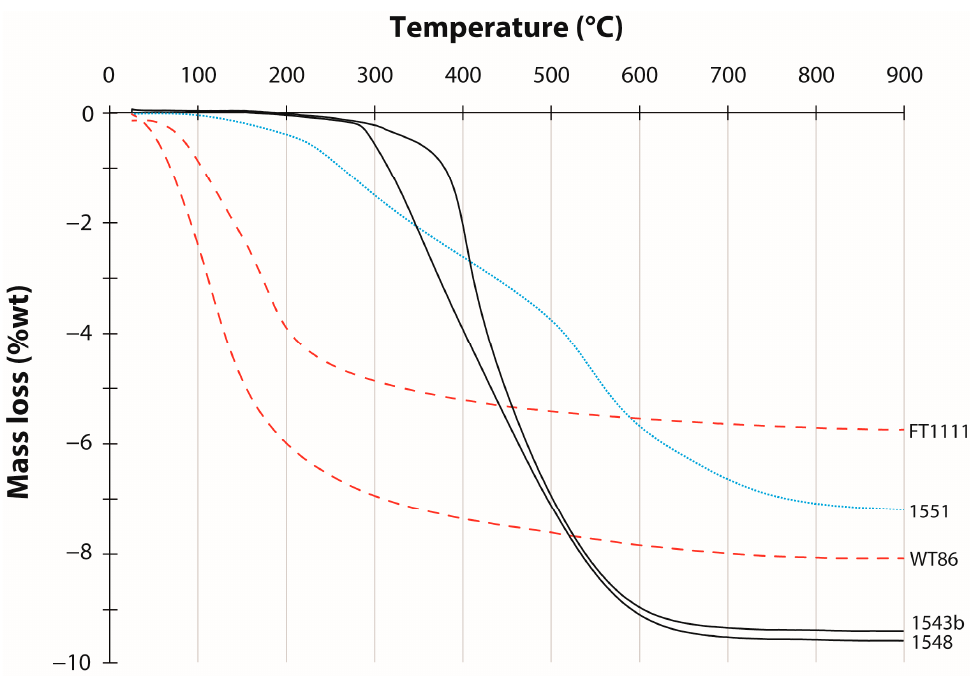
Figure 5. Representative thermogravimetric diagram of the three main behaviors of air-stored samples: black trace show a loss between 300 and 400 °C (sample 1543b-1548), interrupted red trace show a quick loss of water (sample FT1111-WT86), and blue trace show a progressive loss (sample 1551).